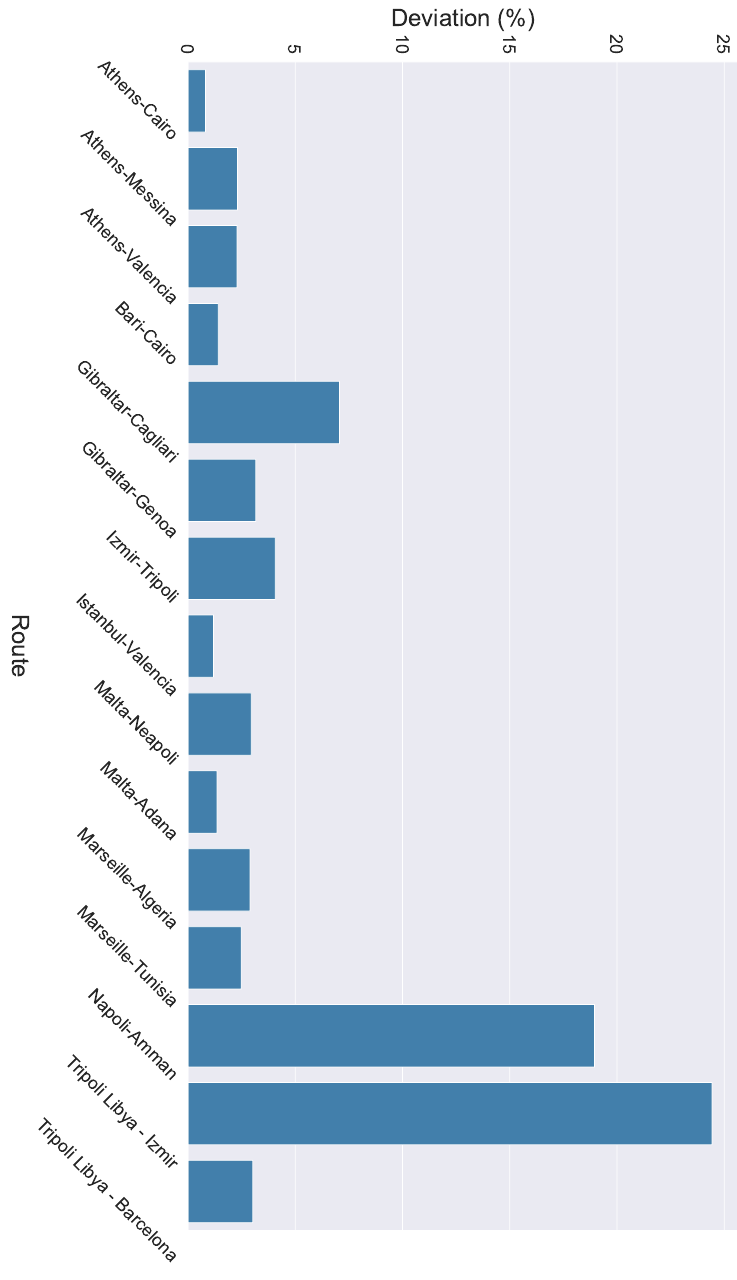
Figure 9. Deviation of wave direction when the alternate routes are